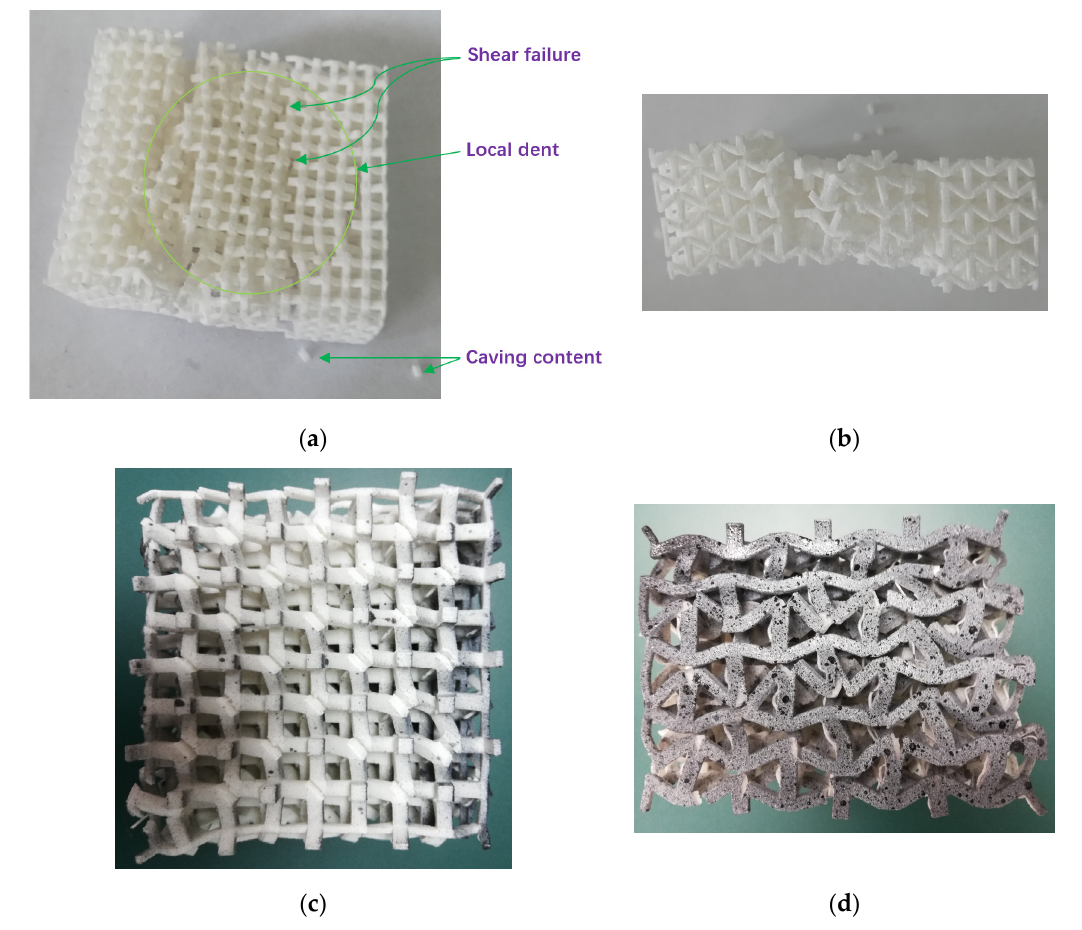
Figure 10. Failure patterns of specimens. ( a ) Impacted surface of impact specimen. ( b ) Side surface of impact specimen. ( c ) Compressed surface of quasi-static specimen. ( d ) Side of quasi-static specimen.